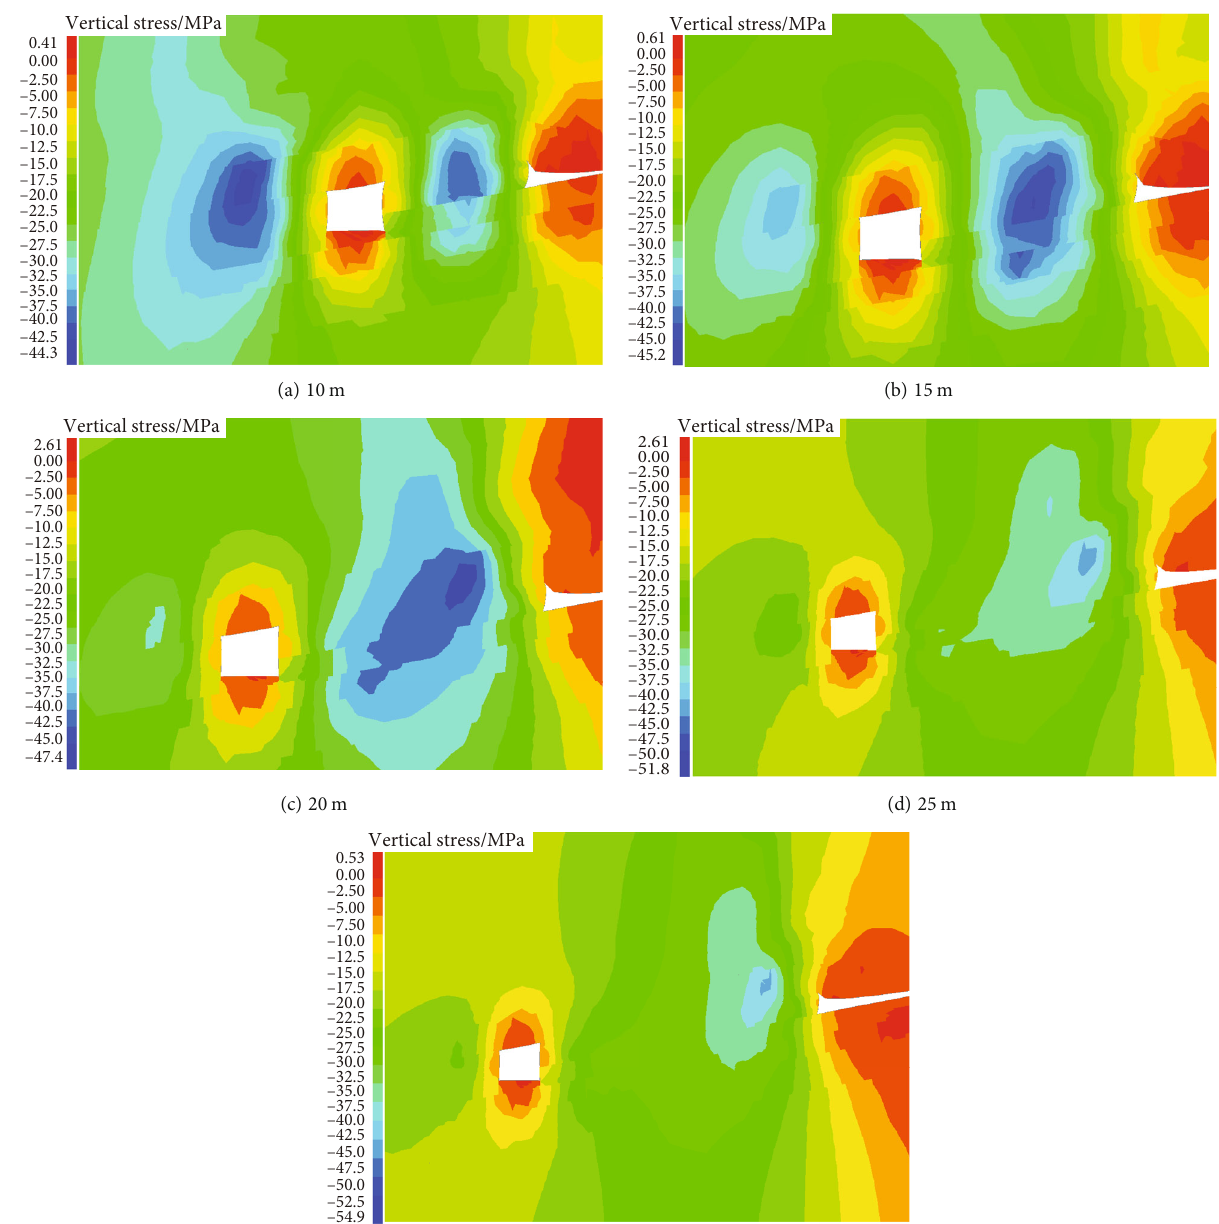
Figure 11: Stress distribution of coal pillars with di ff erent